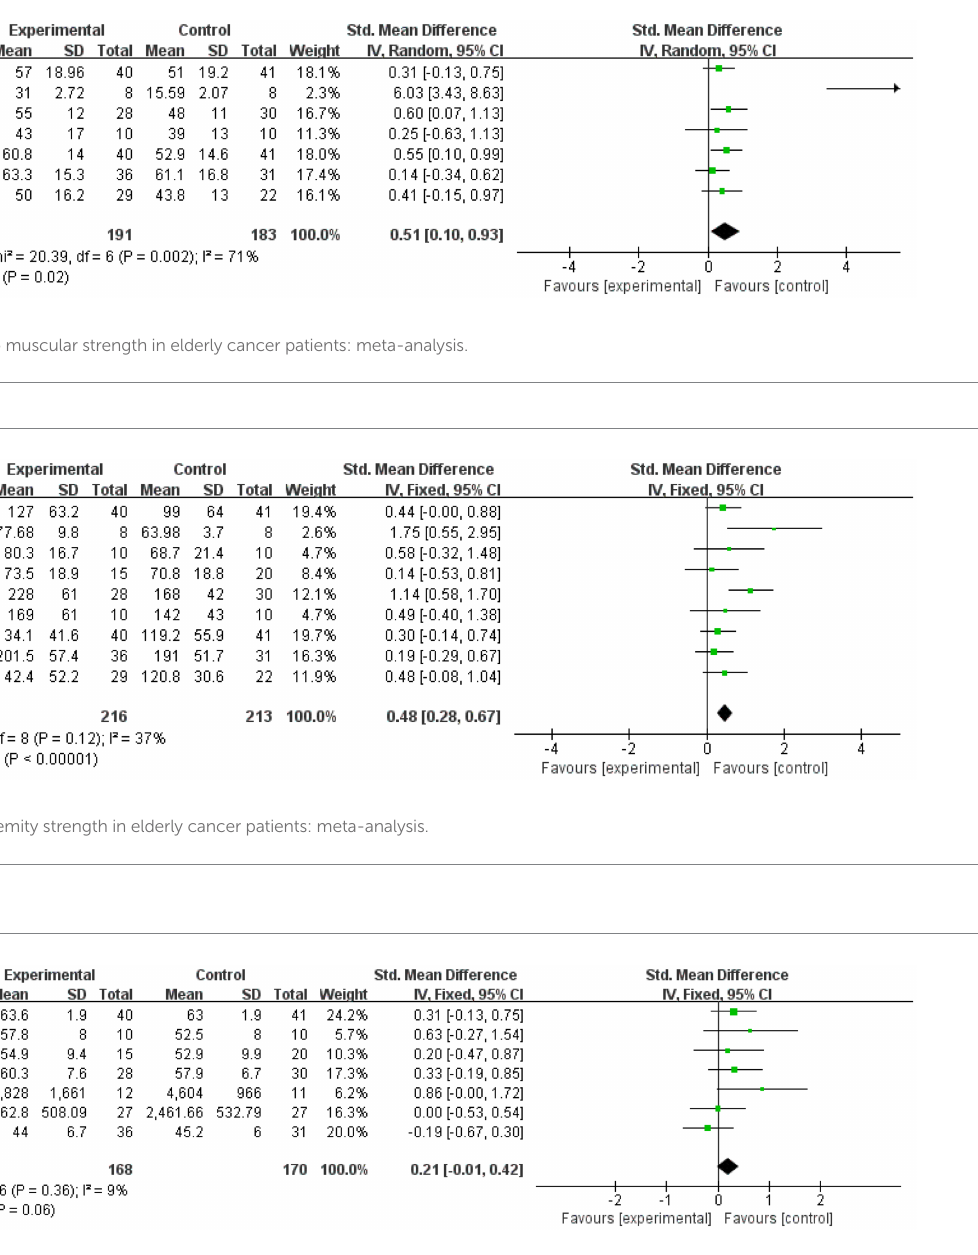
FIGURE 7 Resistance training on muscular morphology in elderly cancer patients: meta-analysis.